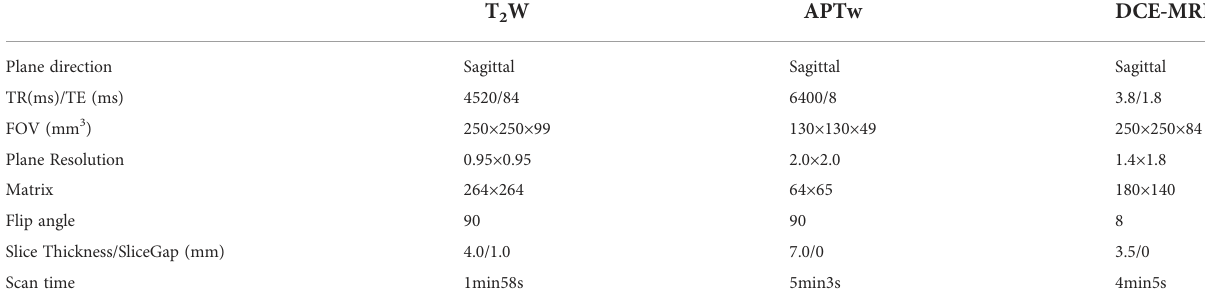
TABLE 2 The parameters of MRI